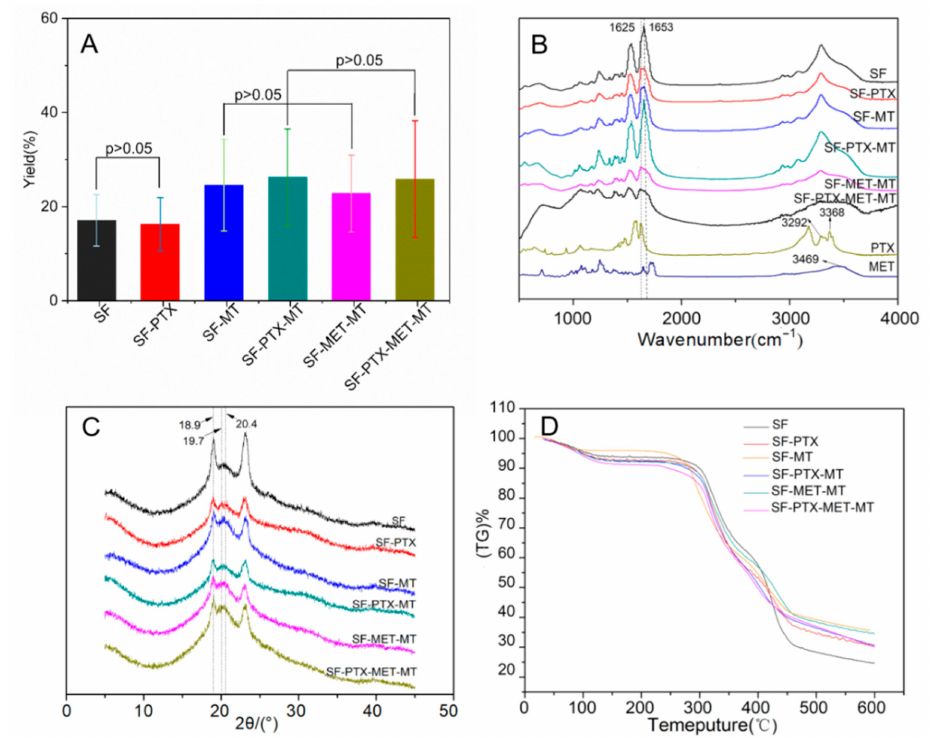
Figure 3. Yield analysis and the secondary structure of SF microspheres prepared with different parameters: ( A ) Yield distribution; ( B ) FTIR image; ( C ) XRD spectrum; ( D ) TGA